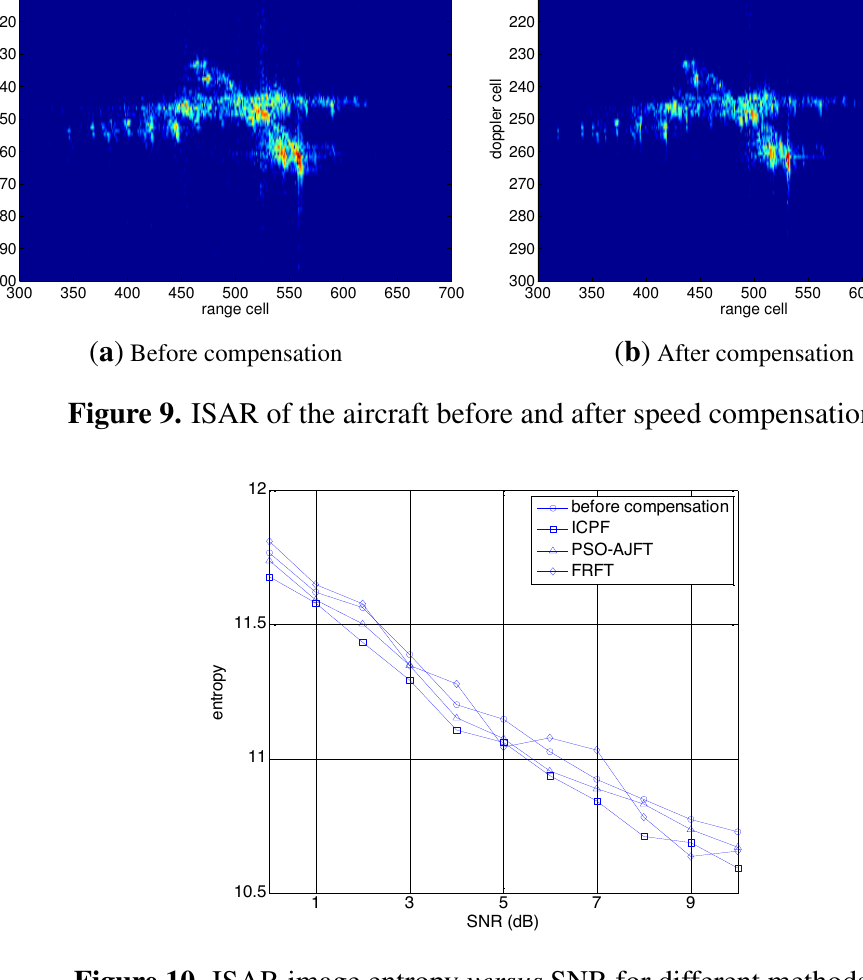
Figure 10. ISAR image entropy versus SNR for different